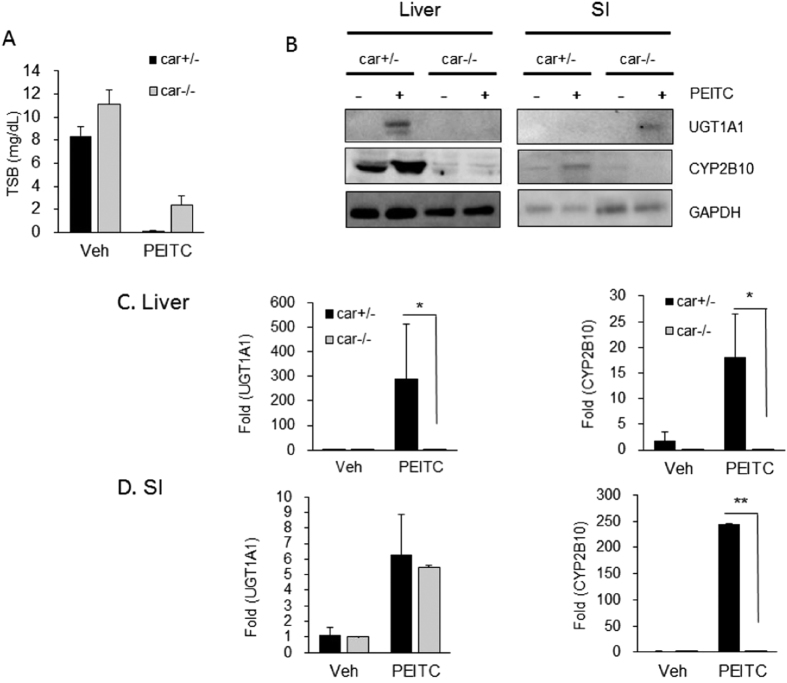
PEITC induction in hUGT1/Car-null mice.Litters were bred to produce hUGT1/Car−/− and hUGT1/Car+/− mice and 10-day old neonatal mice treated with 200 mg/kg on day 10, followed by TSB analysis and tissue preparation on day 12. (A) After treatment, TSB levels were quantitated in hUGT/Car+/− (car+/−) and hUGT1/Car−/− (car−/−) mice. (B) Using total cell extracts from liver and small intestines (SI), Western blots were performed using antibodies toward human UGT1A1 and mouse CYP2B10. The bands have been cropped from the full-length blots but not enhanced in anyway (S6). (C) Total RNA was prepared from liver and small intestines and mRNA expression determined by real time PCR. Values are the means of ±SD (n > 3). Statistically significant differences between vehicle (Veh) and PEITC are indicated by asterisks (Student t test: *P < 0.05; **P < 0.01).